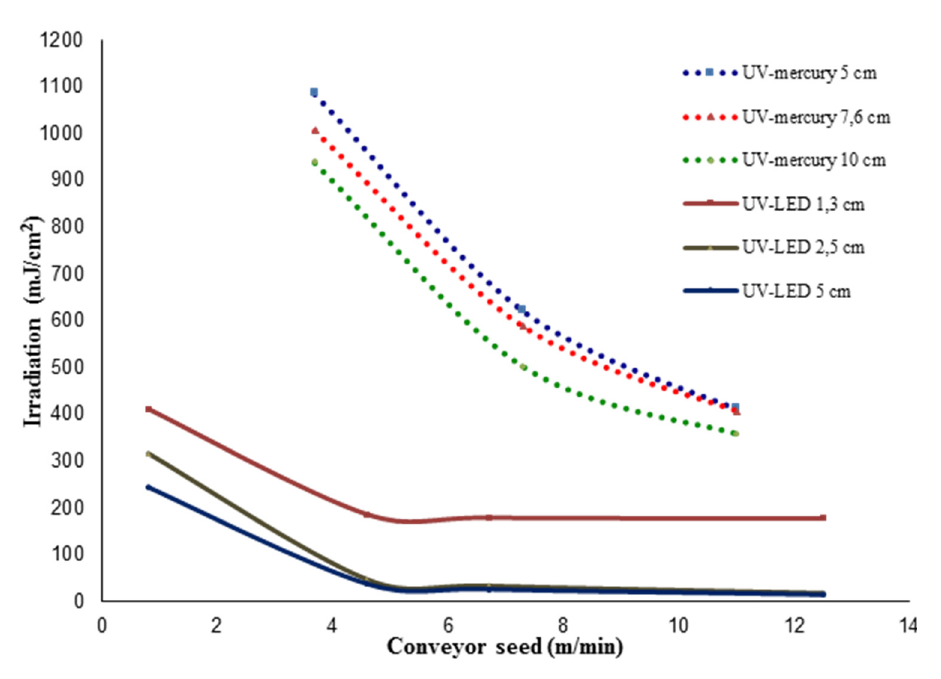
Figure 1. Irradiation of the UV-LED and UV-mercury in function of height and conveyor